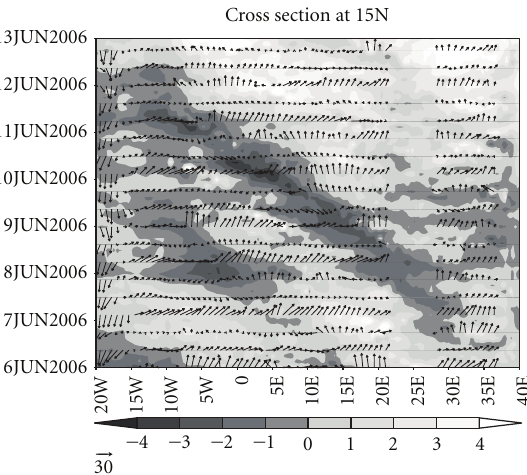
Figure 3: Time-longitude diagram of WRF-Chem EXP30- simulated sea level pressure with the diurnal cycle removed at 15 ◦